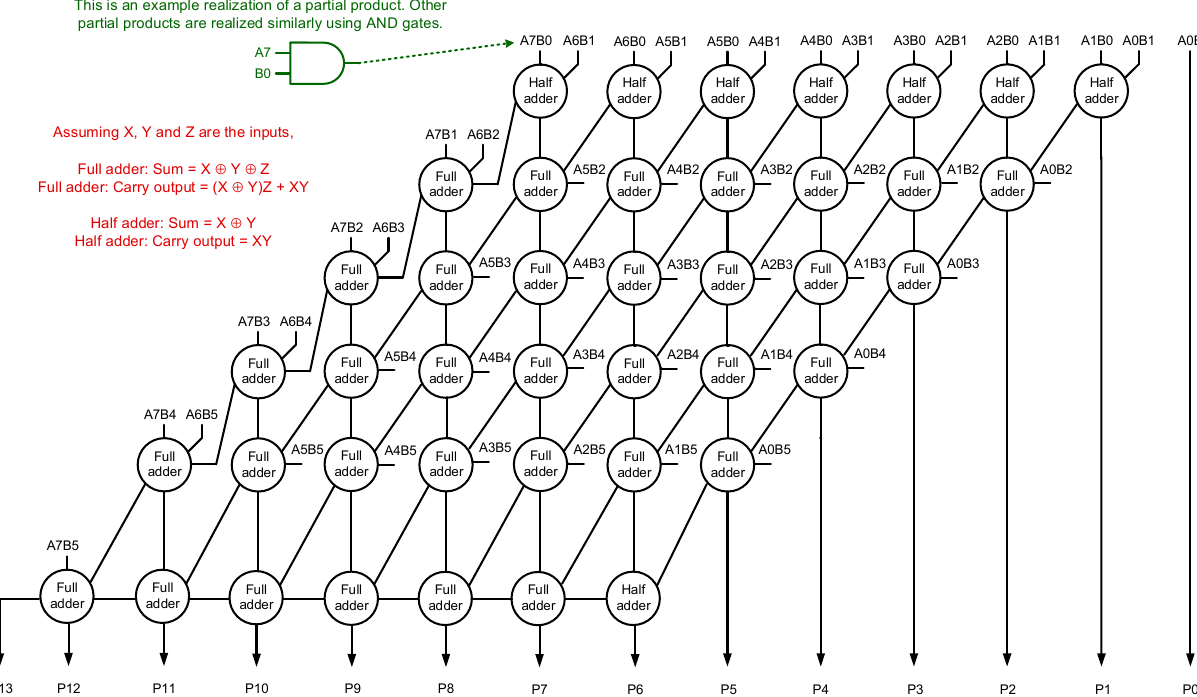
Figure 1. Architecture of 8 × 6 accurate array multiplier.